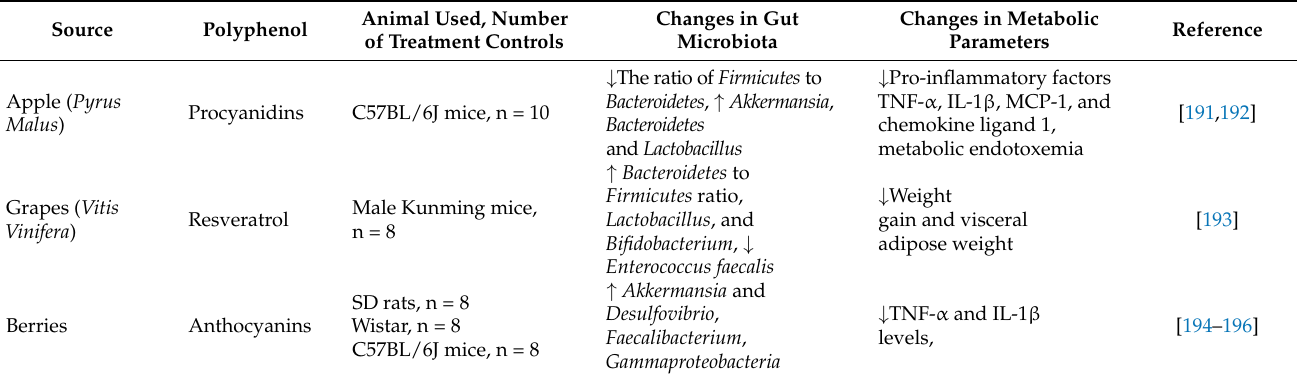
Table 4. Polyphenol’s role on the gut and metabolic